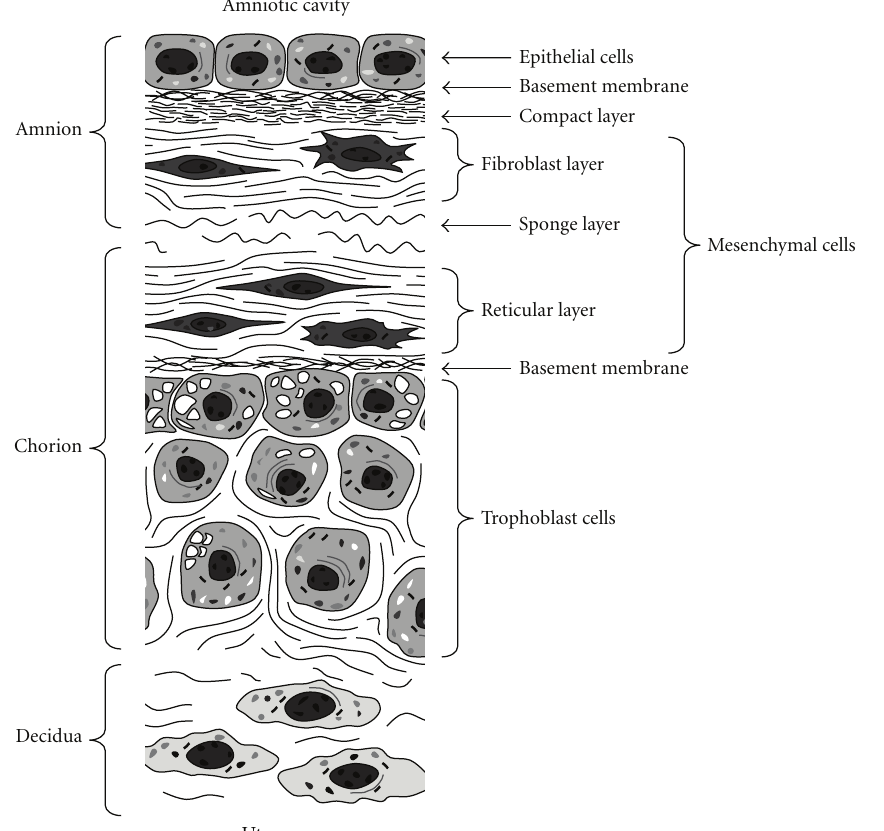
Figure 2: Diagrammatic representation of the human fetal membranes. The amnion and chorion are attached together by the sponge layer. The amnion is formed of a single-layered amniotic epithelial cell and compact and fibroblast layers. The chorion is formed of multilayered trophoblast cells and reticular layer. The fibroblast layer of the amnion and the reticular layer of the chorion contain mesenchymal cells. The mesenchymal cells exhibit plasticity among fibroblast/myofibroblast cells and